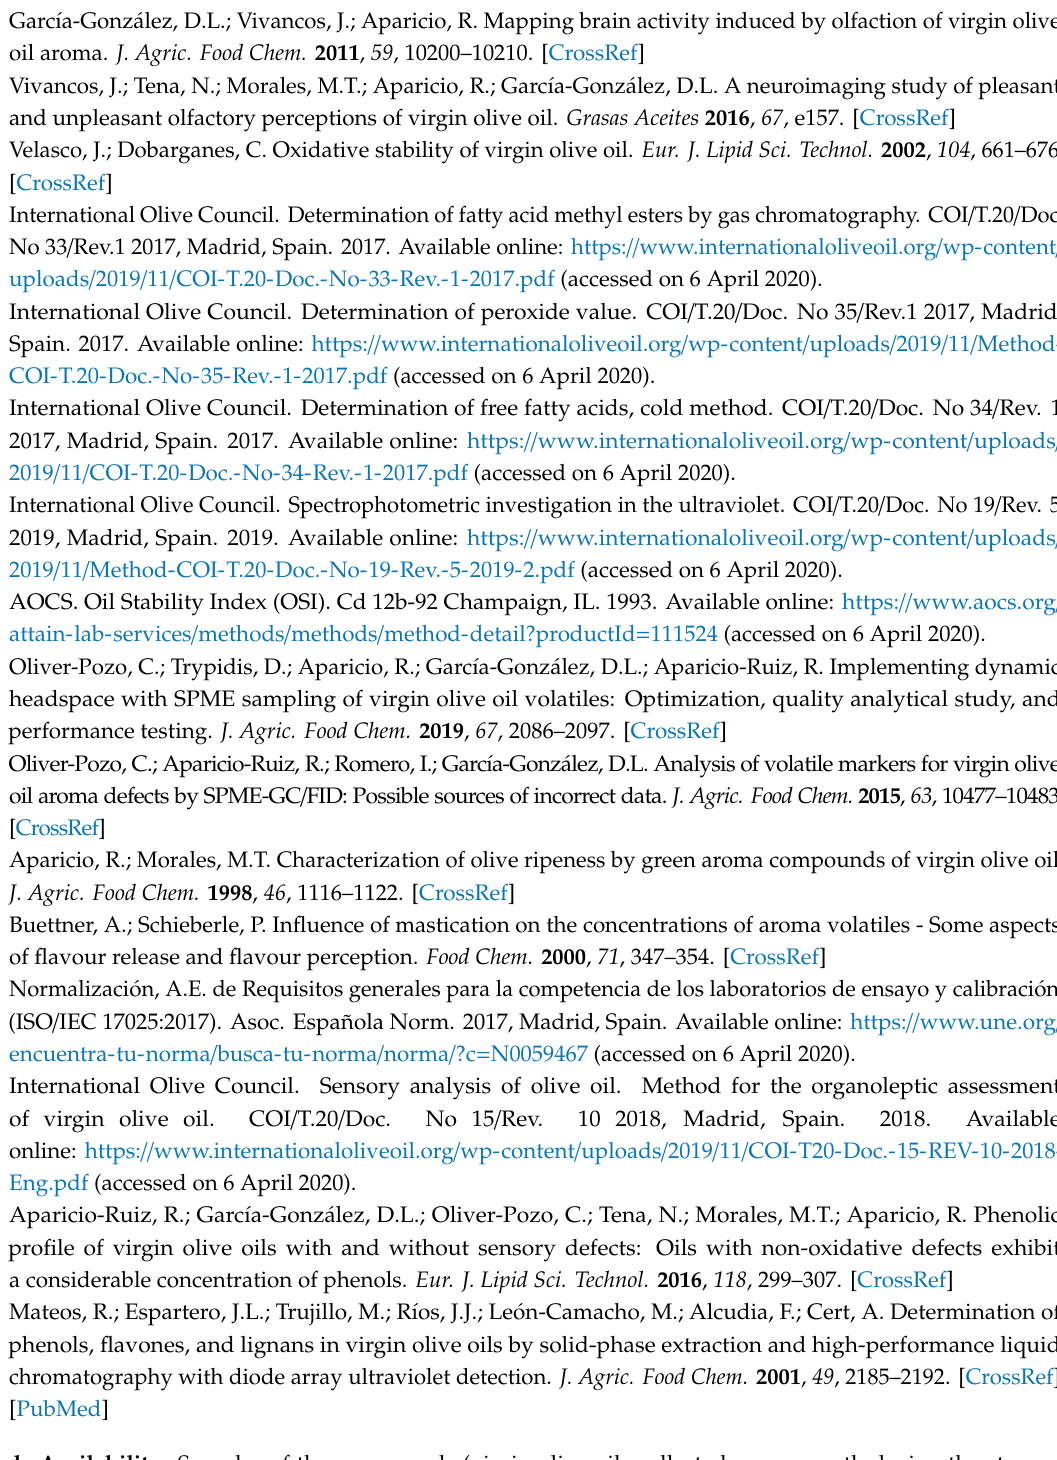
Sample Availability: Samples of the compounds (virgin olive oils collected every month during the storage experiment) are available from the